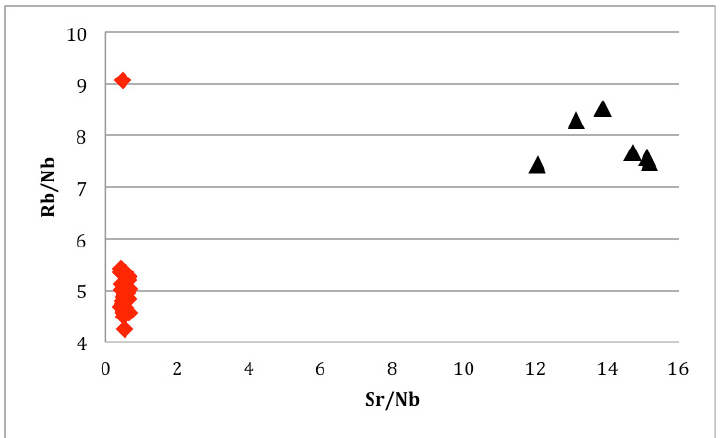
Figure 2d. Rb/Nb vs Sr/Nb. Stromboli: red diamonds; Melos (Glasgow collection): black triangles. Stromboli archaeological material has an Rb/Nb which is tightely set between 4 and 6 (but with an outlier at 9) and low Sr/Nb; Melos, geological material, on the other hand has an Sr/Nb ratio which is between 12 and 16 and is very distinct from the Lipari/Stromboli groups. See also Fig 2e.